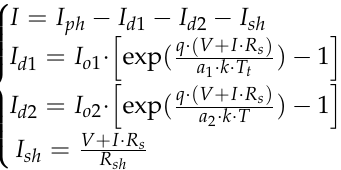
Figure 2. Equivalent circuit diagram for DDM.